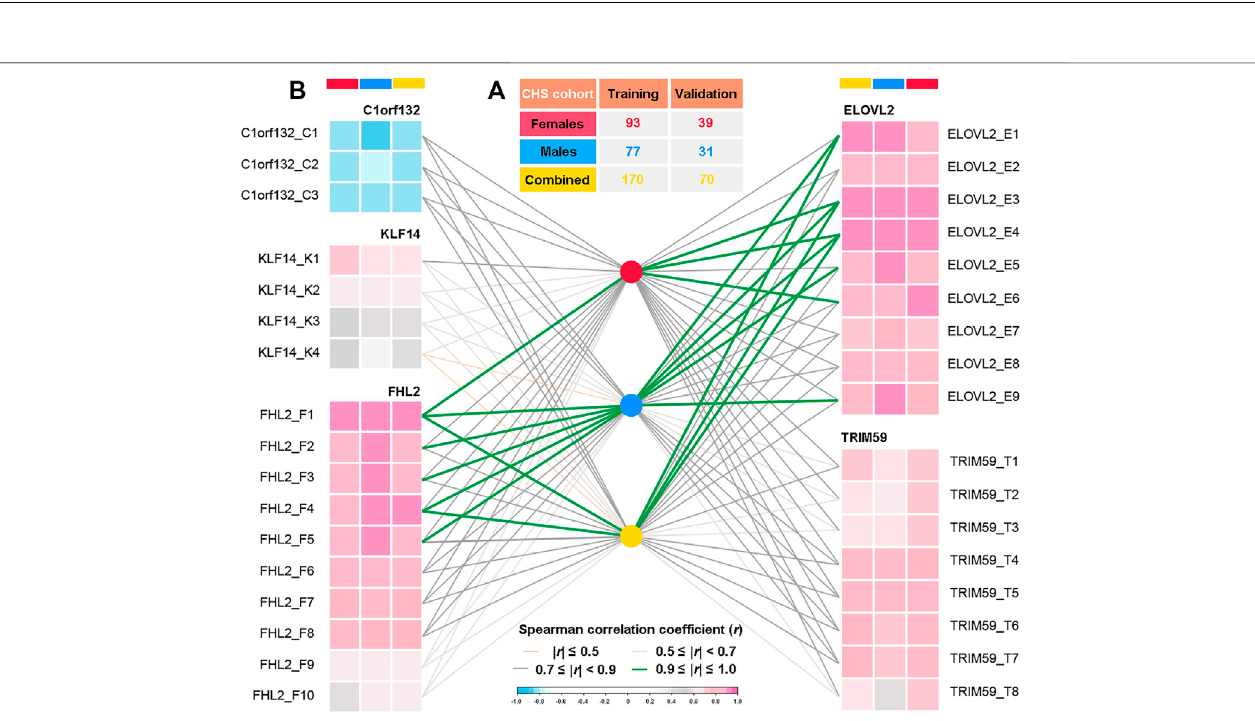
FIGURE1| Detailedmeta-analysisresults (A) andcorrelationcoef fi cientranking (B) ofthecandidateage-associatedgeneset.( n ,samplesize; |r| ,absolutevalueof correlation coef fi cient; CI, con fi dence interval; p , signi fi cance of Z test.)